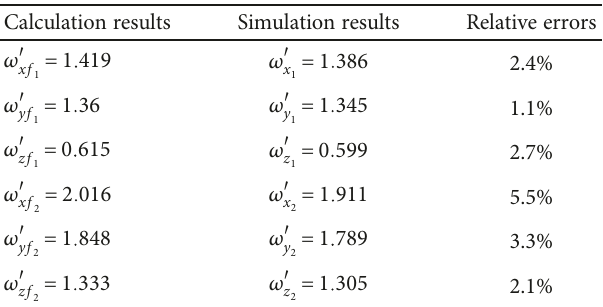
Table 22: Relative errors of calculation and simulation results for storage tank.